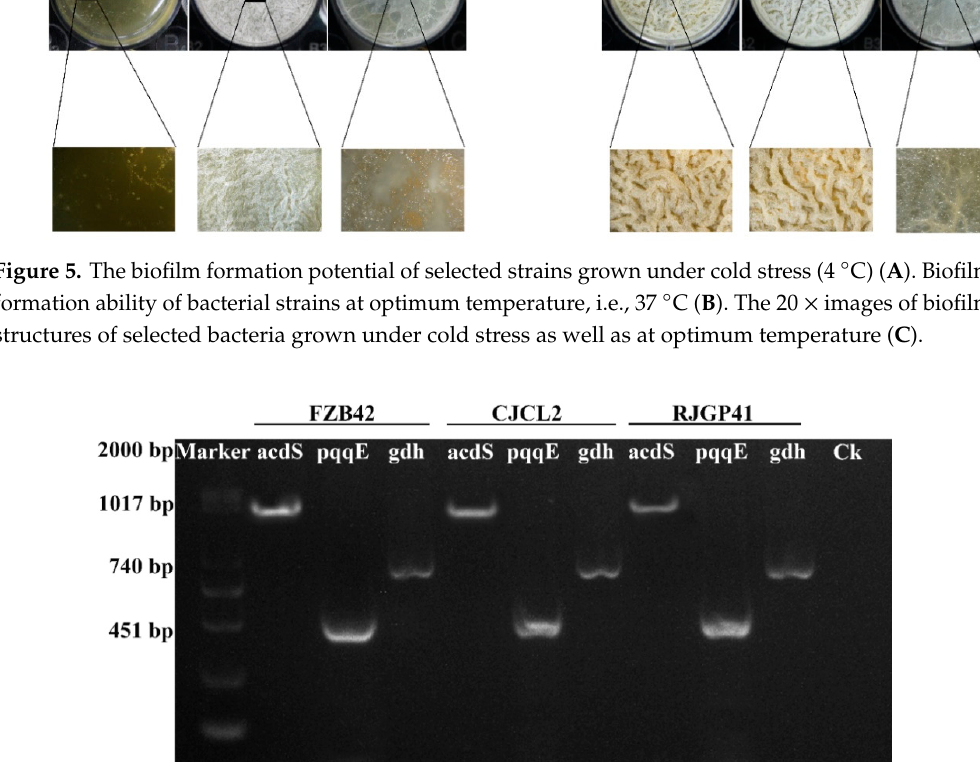
Figure 6. The Gel electrophoresis showing the detection of genes related to plant growth promoting traits in different